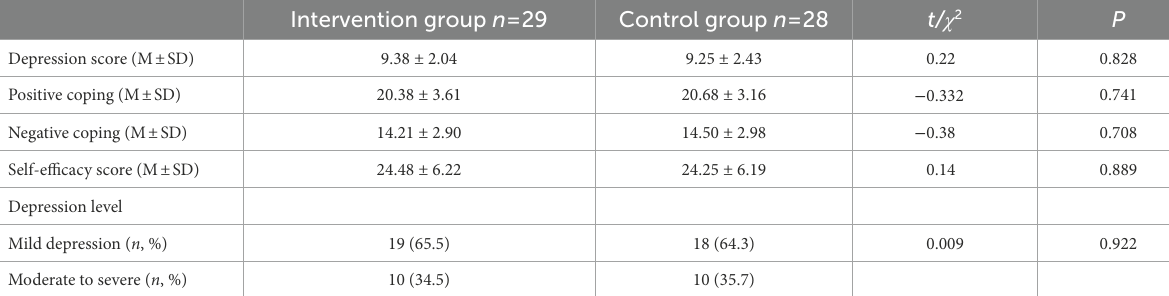
TABLE 3 Depression, coping, and self-efficacy at baseline for both